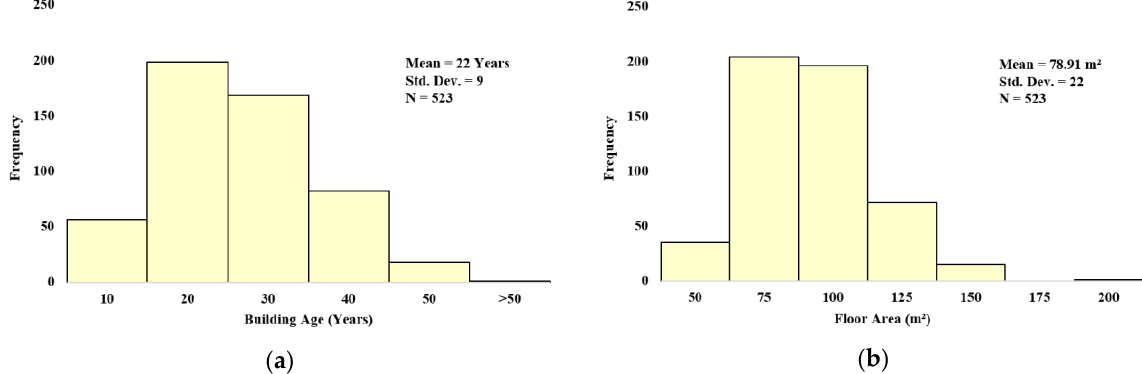
Figure 5. Histograms of ( a ) building age and ( b ) floor area of all houses.